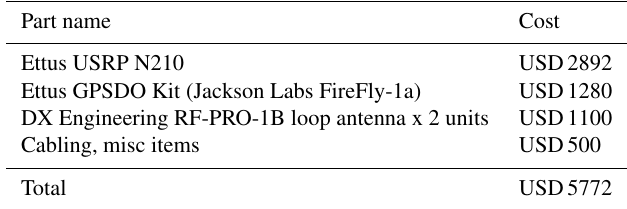
Table 1. Receive system at CARL (March